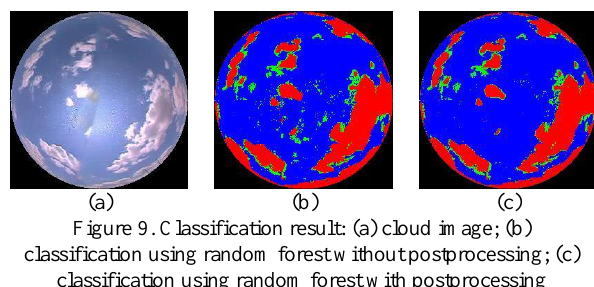
Figure 9. Classification result: (a) cloud image; (b) classification using random forest without postprocessing; (c) classification using random forest with